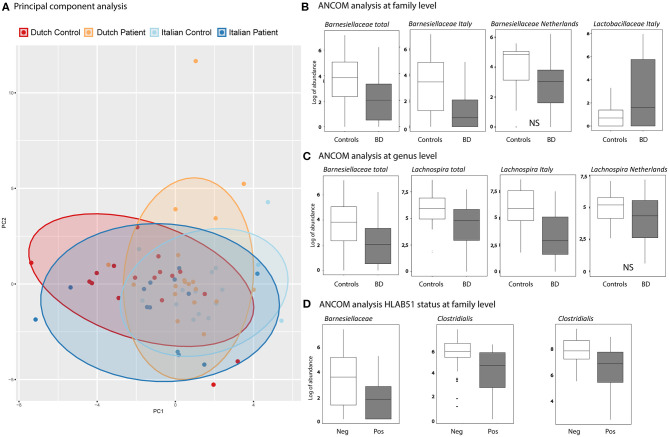
(A) Principal components analysis (PCA), based on GM genera abundance, showing Dutch HC (red), Dutch BD patient (orange), Italian HC (light blue), Italian BD patient (dark blue). (B,C) Boxplots show the results of ANCOM analysis at family (B) and genus (C) level. Log of abundance in both healthy controls (white boxes) and BD patients (gray boxes). NS is non-significant. (D) ANCOM analysis at family level of HLAB51 positive (gray boxes) and HLAB51 negative patients (white boxes) displayed in log of abundance.